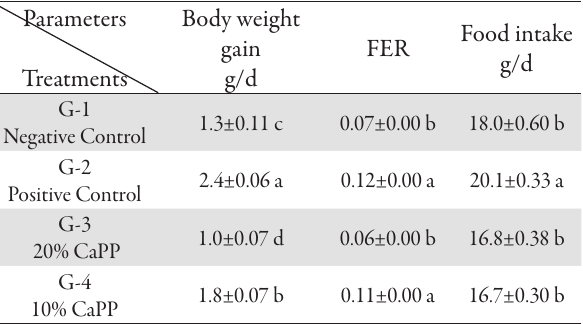
Tab. 2. The mean value of Body Weight Gain, Feed